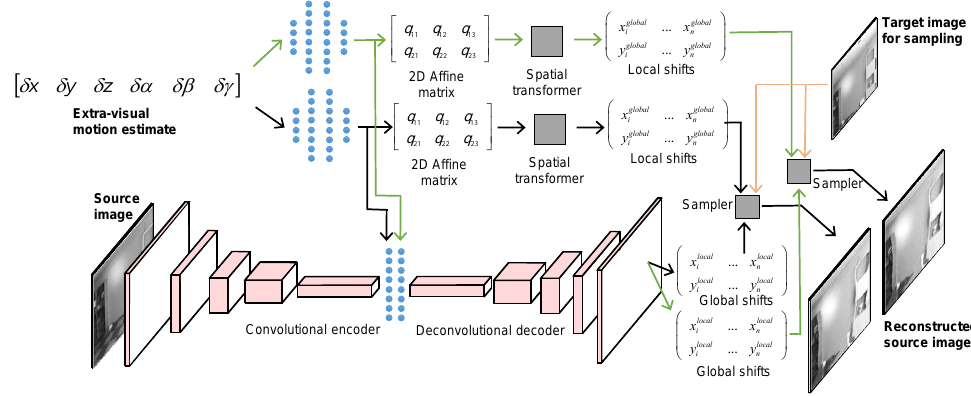
Figure 1. MHDE network diagram depicting an architecture that computes two hypotheses. We experimented with architectures that generated up to 20